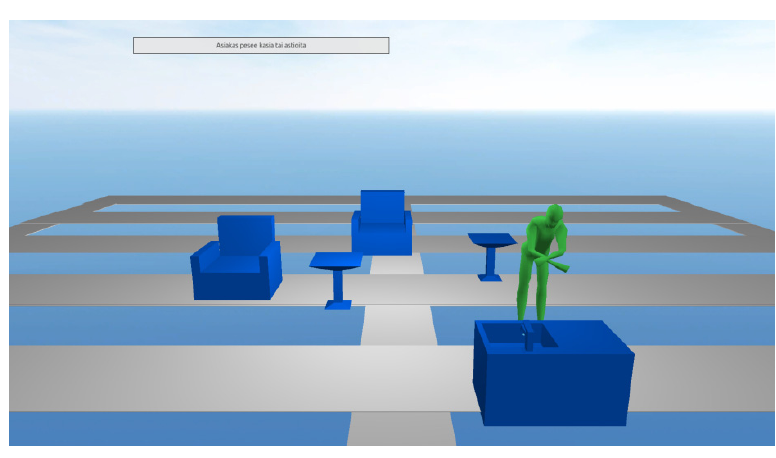
Figure 2. Initial